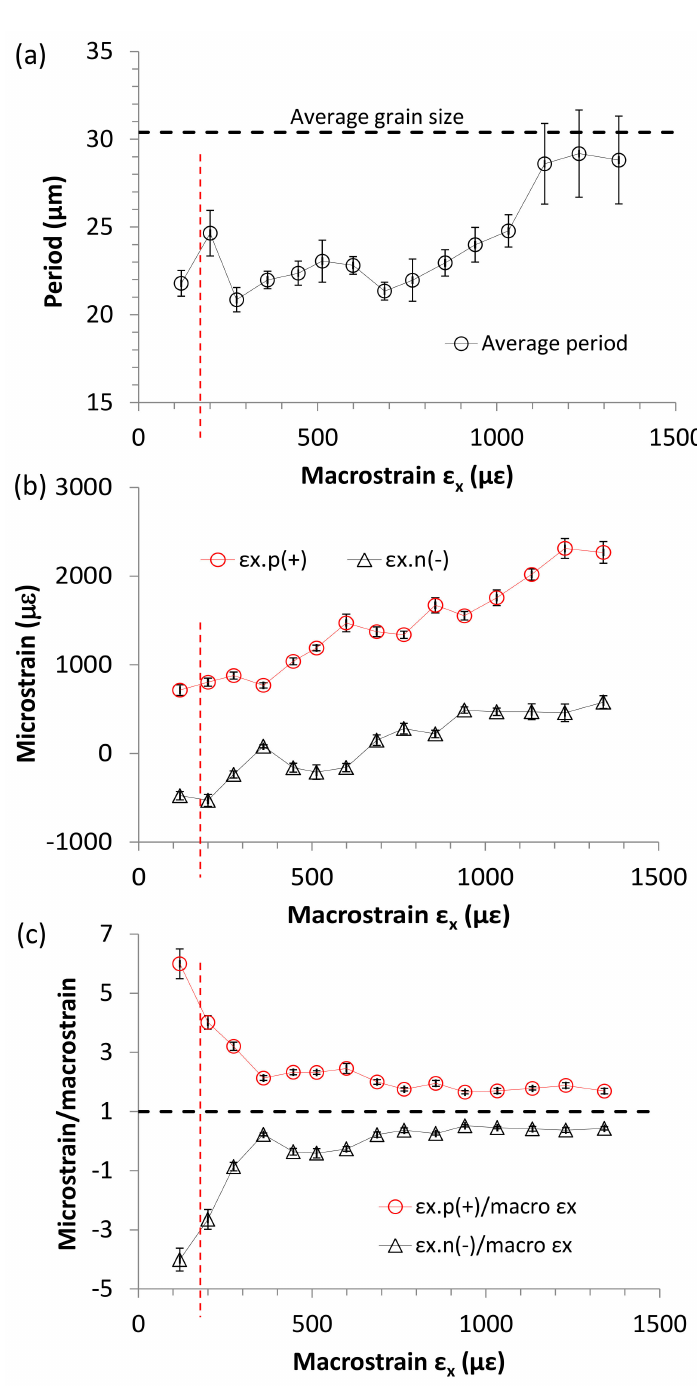
Figure 9. Dependence of the microstrain period, microstrain amplitude and strain concentration factor on the macrostrain. ( a ) average period versus the macrostrain; ( b ) average peak values of the positive and negative microstrain localizations versus the macrostrain; ( c ) average strain concentration factors of the positive and negative microstrain localizations versus the macrostrain. Error bar is the standard error. The vertical dotted red line corresponds to the noise-to-strain ratio of